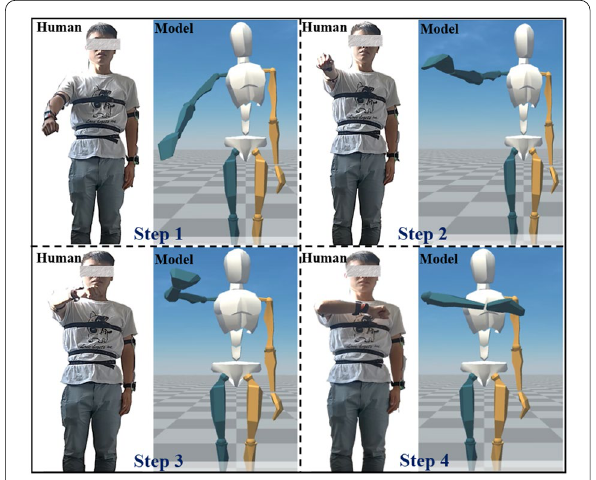
Figure 2 Modeling and simulation of